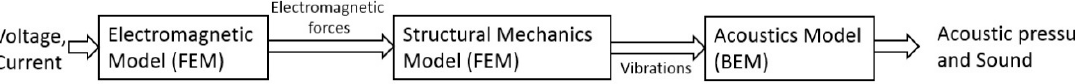
Figure 2. Numerical simulation stages .